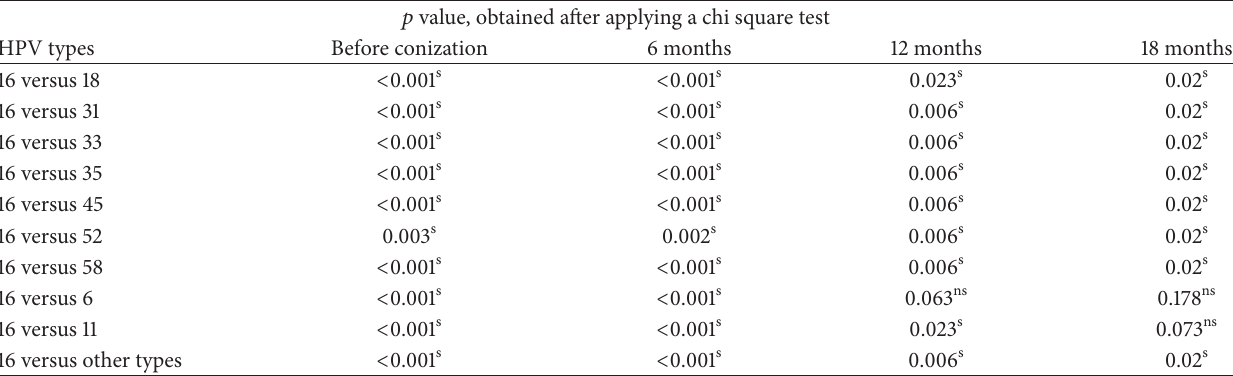
Table 2: The 𝑝 value obtained by comparing HPV 16 to the other HPV types using 𝜒 2 test. 𝑝 value, obtained after applying a chi square test